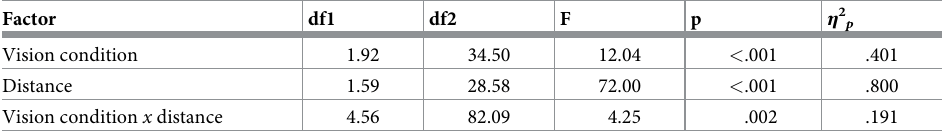
Table 16. Results of the two-factor ANOVA with repeated measures (3 distances; 4 vision conditions) for the con- stant error of predicted putt length. Corrected by Greenhouse-Geisser � . Factor df1